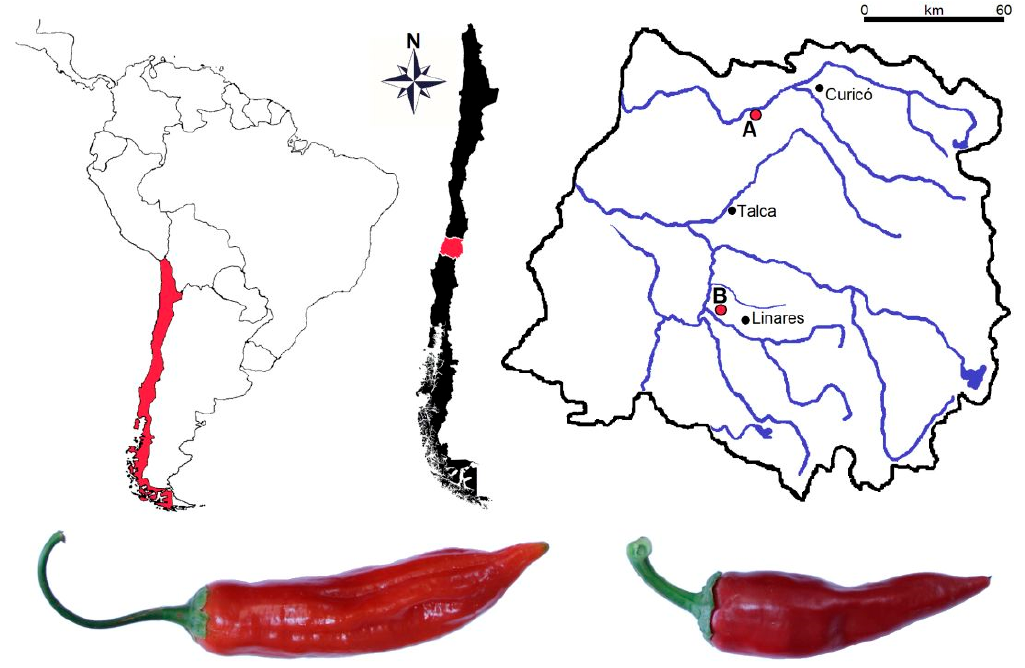
Figure 1. Chile and the region of Maule with the main cities, rivers, and the two study localities. ( A ) Villa Prat and ( B ) Palmilla. The two main landraces of chili pepper produced in these localities are chileno negro (left fruit) and cacho de cabra (right fruit).